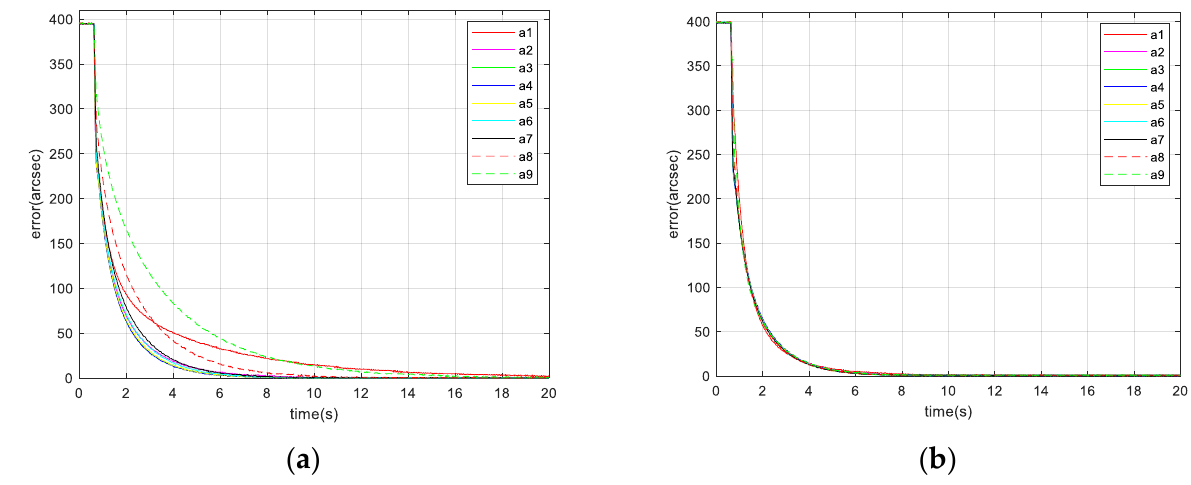
Figure 12. IBCLT errors of different static targets: ( a ) fixed gain and ( b ) variable gain. Figure 13 shows the frequency domain characteristics of the achromatic Risley prism system using the fixed gain control and variable gain control techniques when tracking target a 9 .